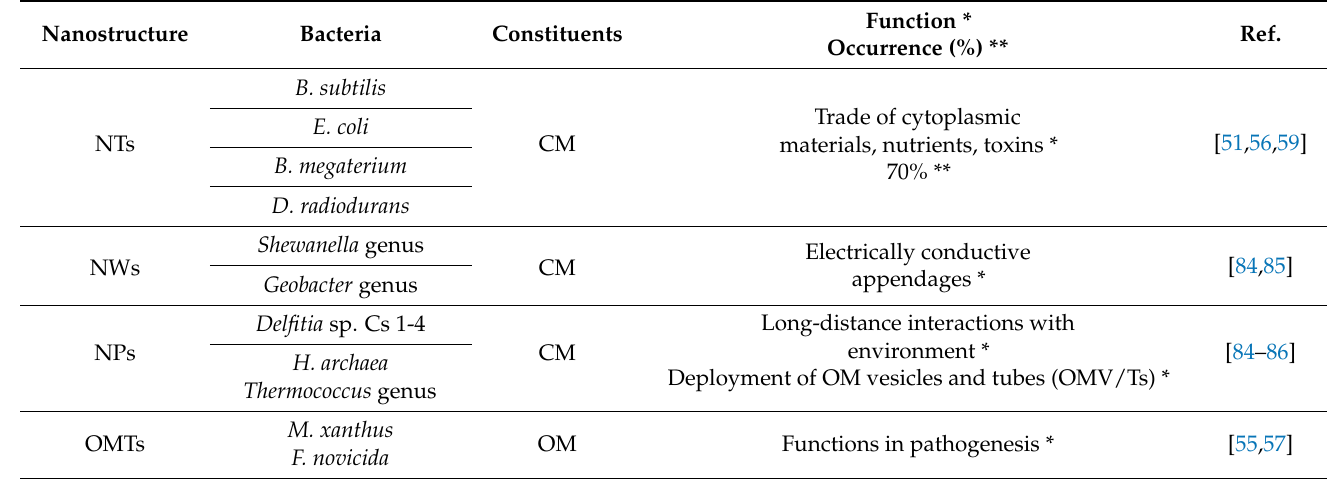
Table 5. The three most applied methods to synthetize CNTs.